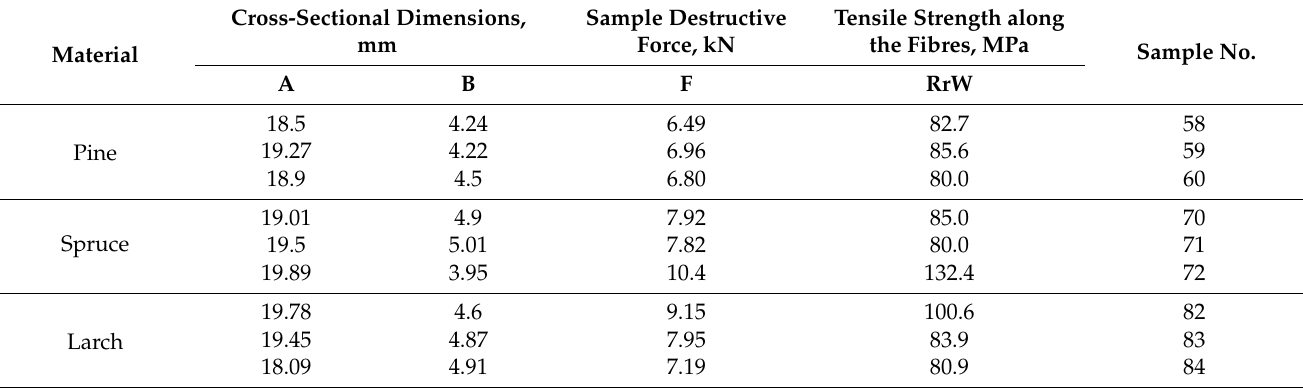
Table 2. Tensile testing along the fibres of respective cycle 1